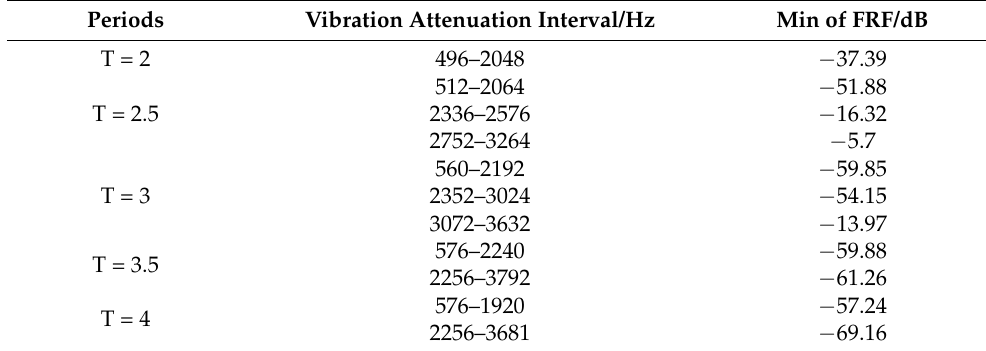
Table 5. Vibration isolation interval of GFRP wave spring with different periods.